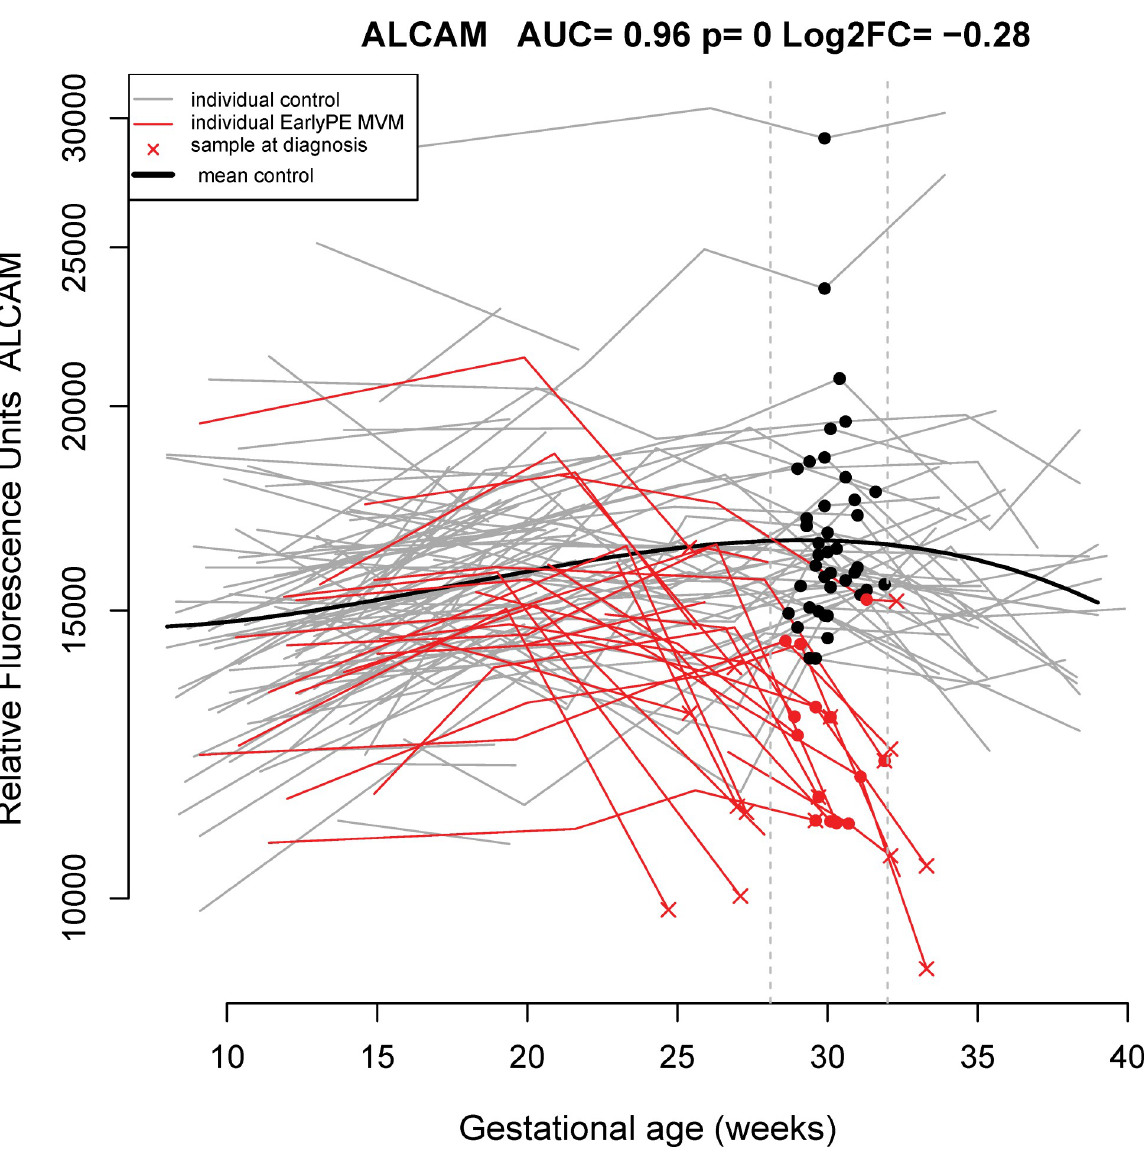
Fig 4. Longitudinal maternal plasma ALCAM abundance in normal pregnancy and early preeclampsia cases, highlighting differences at 28.1–32 weeks. ALCAM: activated leukocyte cell adhesion molecule; AUC: area under the receiver operating characteristic curve; early PE: early preeclampsia; FC: fold change; MVM: maternal vascular